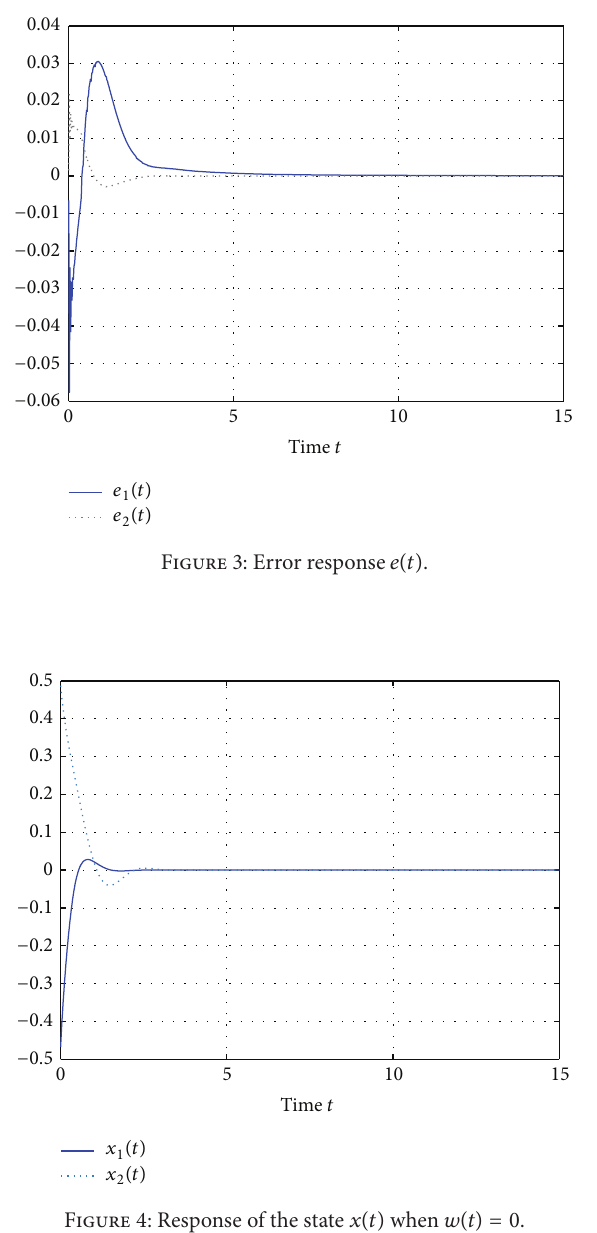
Figure 4: Response of the state 𝑥(𝑡) when 𝑤(𝑡) = 0